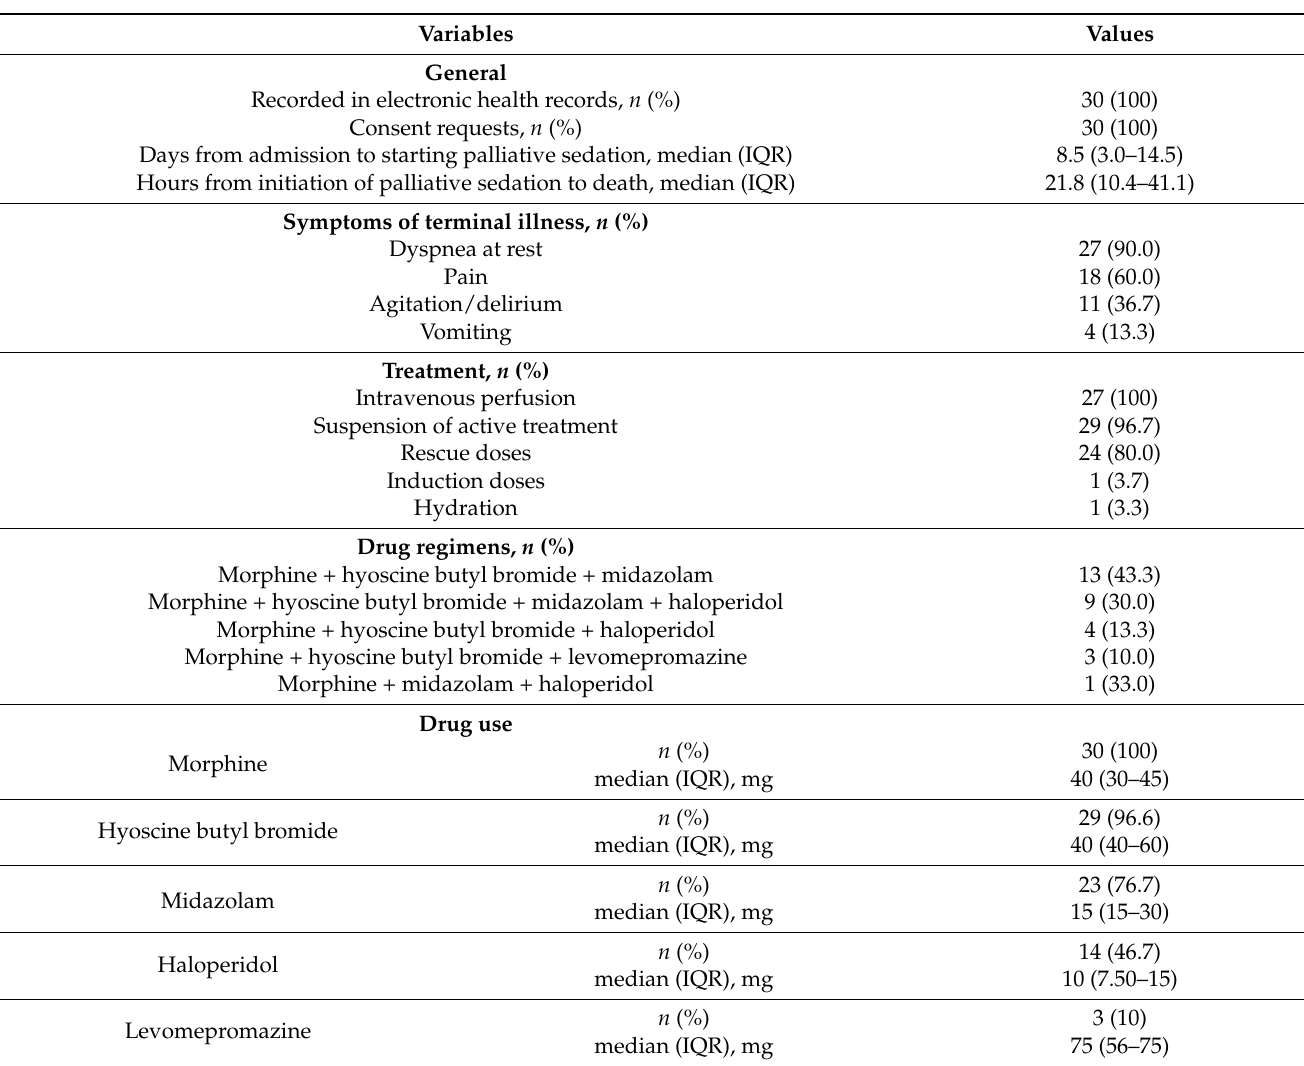
Table 2. Characteristics of palliative sedation use to alleviate refractory symptoms prior to death in inpatients with COVID-19 in an acute medical ward ( n =